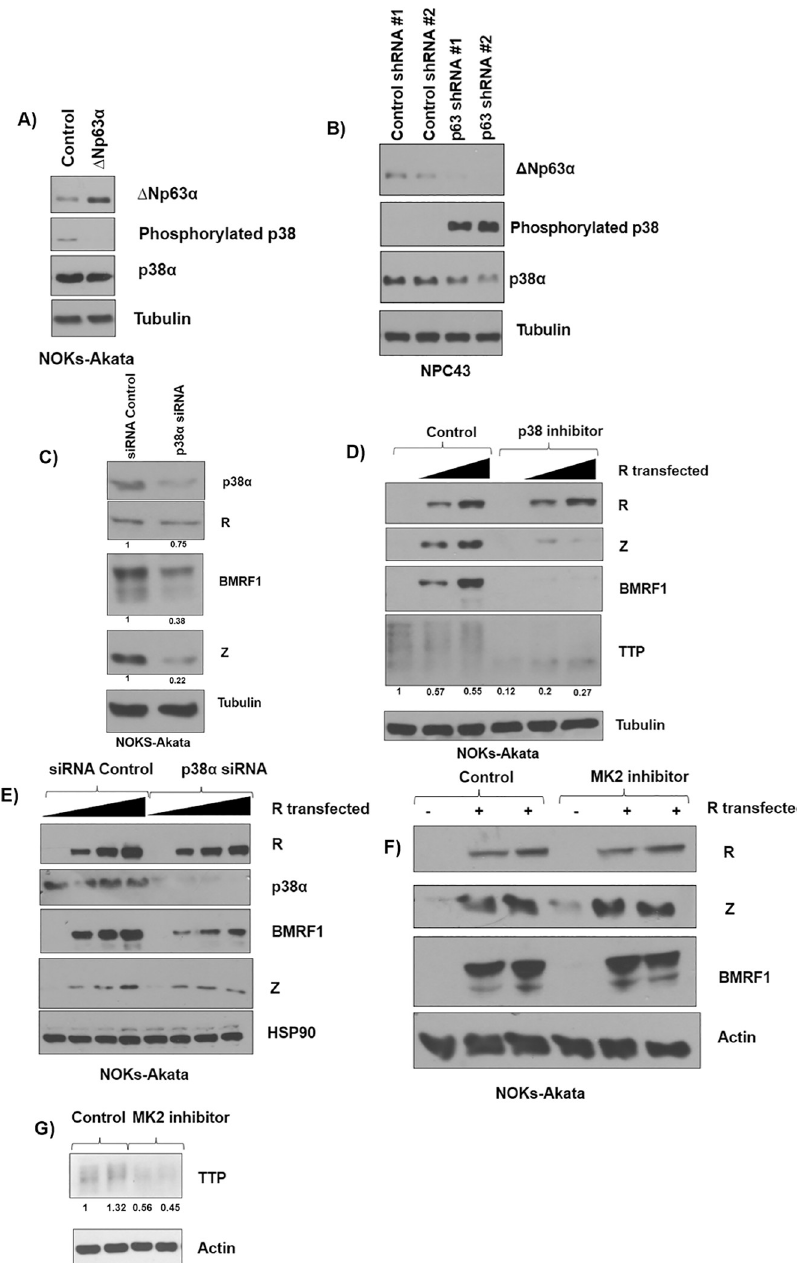
Fig 11. Δ Np63 α over-expression decreases p38 kinase activity, which is required for R mediated lytic reactivation. A) Immunoblot analysis was performed on protein lysates harvested from NOKs-Akata cells infected with a lentivirus vector expressing Δ Np63 α , or a control lentivirus vector, and expression of Δ Np63 α , phosphorylated (activated) p38, total p38 α (MAPK14), and tubulin (a loading control) was assessed. B) NPC43 cells were infected with a lentivirus expressing shRNA targeting p63 or a control sequence, then harvested for western blots to examine the expression of Δ Np63 α , phosphorylated p38, total p38 α and tubulin. Note that these samples were also used in Fig 2B. C) NOKs- Akata cells were transfected with either a control siRNA or an siRNA targeting p38 α (MAPK14), and two days later immunoblot analysis was performed to examine expression of p38 α (MAPK14), R, BMRF1, Z, and tubulin as indicated. Quantitation of R, BMRF1 and Z expression was determined through ImageJ, normalized to tubulin, and the siRNA control sample was set as 1. D) NOKs-Akata cells were transfected with or without an R expression vector in the presence or absence of 10 μ M p38 MAPK inhibitor SB202190. Immunoblot analysis was performed two days later to examine expression levels of Z, R, BMRF1, TTP and tubulin as indicated. Expression of TTP was quantitated with ImageJ, normalized to tubulin with the first lane set as 1. E) NOKs-Akata cells were transfected with either